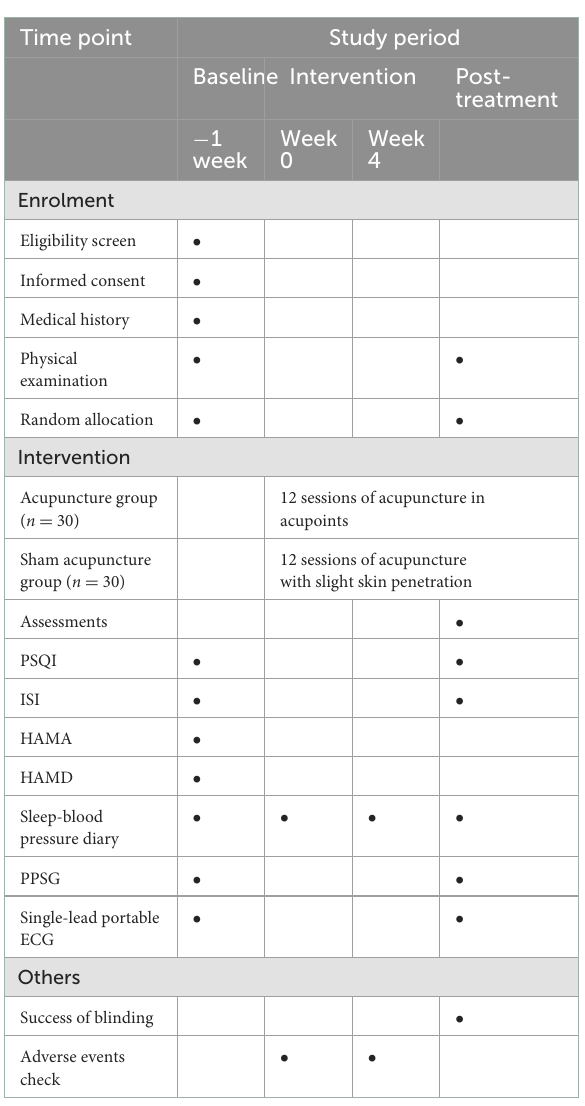
TABLE 1 Schedule of enrolment, interventions, and